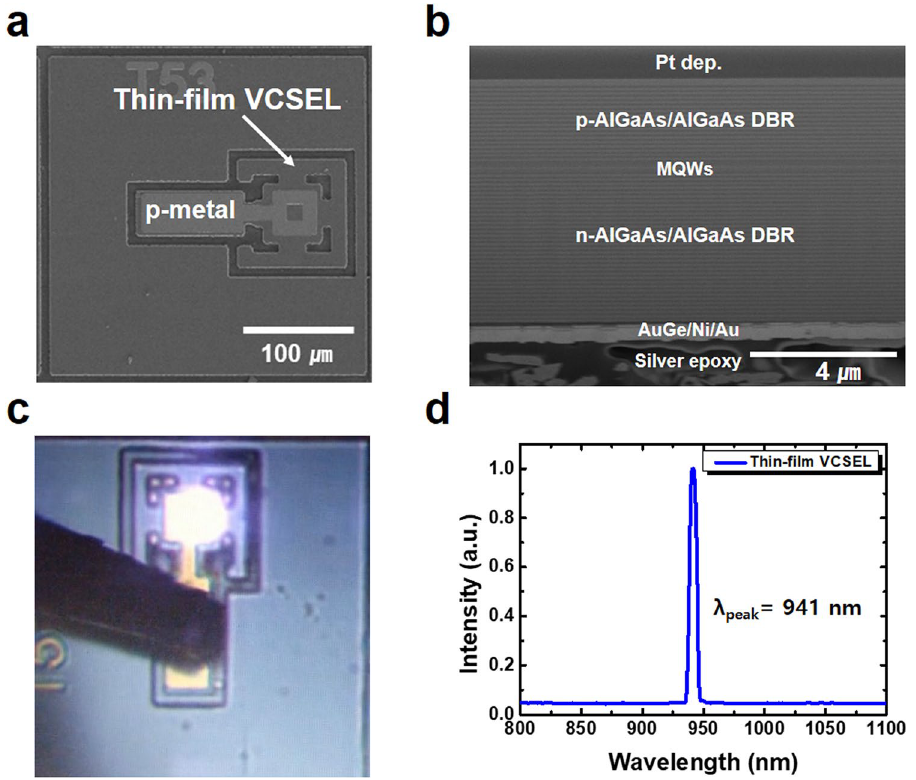
Figure 4. Fabrication of top-emitting 940-nm thin-film VCSELs. ( a ) Top-view and ( b ) cross-sectional SEM image of the fabricated thin-film VCSELs obtained from FIB milling (c) A microscopy image of the 940-nm